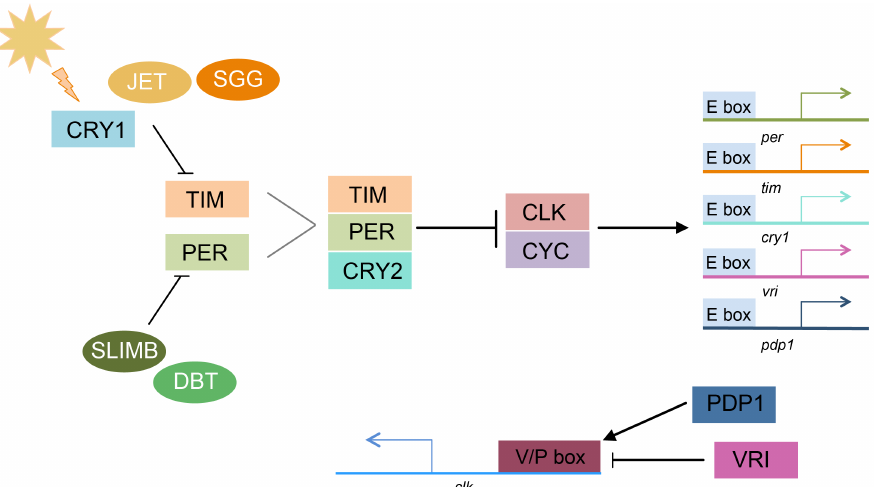
Figure 1. Simplified pathway of the core Lepidopteran circadian clock. Arrows represent activation. Vertical lines represent inhibition. Gray lines indicate dimer formation. During the day, light activates the blue light photoreceptor CRYPTOCHROME1 (CRY1). CRY1 activation leads to SHAGGY (SGG) tagging TIMELESS (TIM) for degradation by JETLAG (JET). The PERIOD (PER) monomer is tagged for degradation by SLIMB when not bound to TIM. DOUBLETIME (DBT) regulates PER activity through phosphorylation. The PER/TIM heterodimer forms a complex with CRYPTOCHROME2 (CRY2) and enters the nucleus, where PER and CRY2 inhibit the activity of the CLOCK/CYCLE heterodimer. CLK/CYC binds to E-box enhancers to activate transcription. A second feedback loop is comprised of VRILLE (VRI) and PDP1, which bind to the V/P box of the clk promoter cyclically. VRI acts as repressor of clk transcription but PDP1 activates clk transcription. Modified from